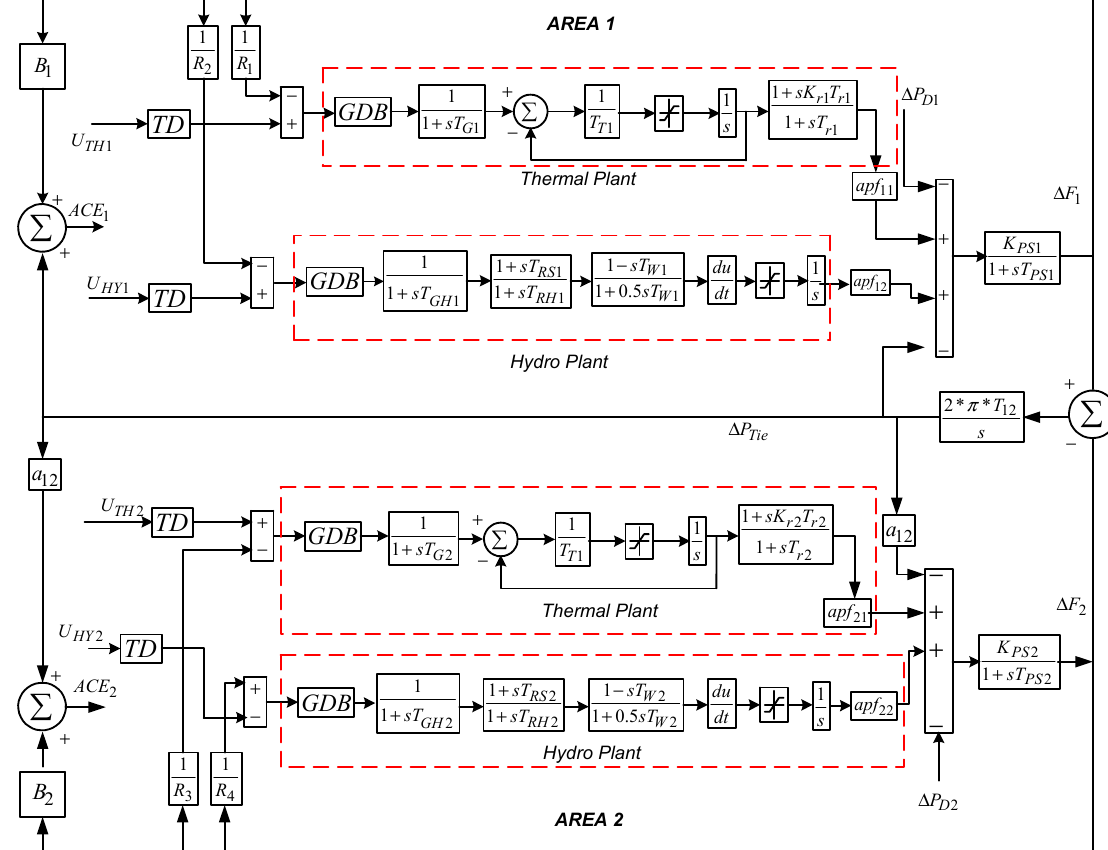
Figure 1. Two-area thermal and hydro power model.